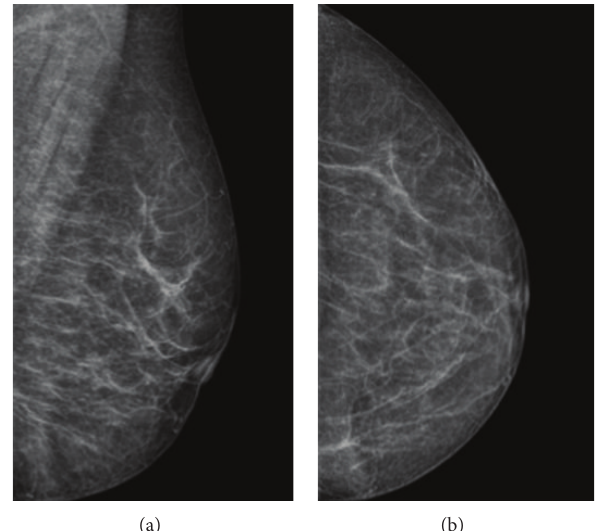
Figure 9: Posttreatment mammography : left breast mediolateral oblique (a) and craniocaudal (b) mammographic views confirmed complete left breast lesion resolution after the 3rd chemotherapy